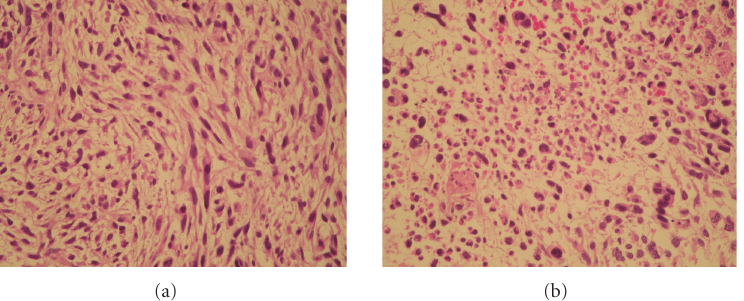
Figure 1: Leiomyosarcoma composed of a dominant population of neoplastic spindle cells: (a) intermingled with giant neoplastic cells and multifocal necrosis (b).